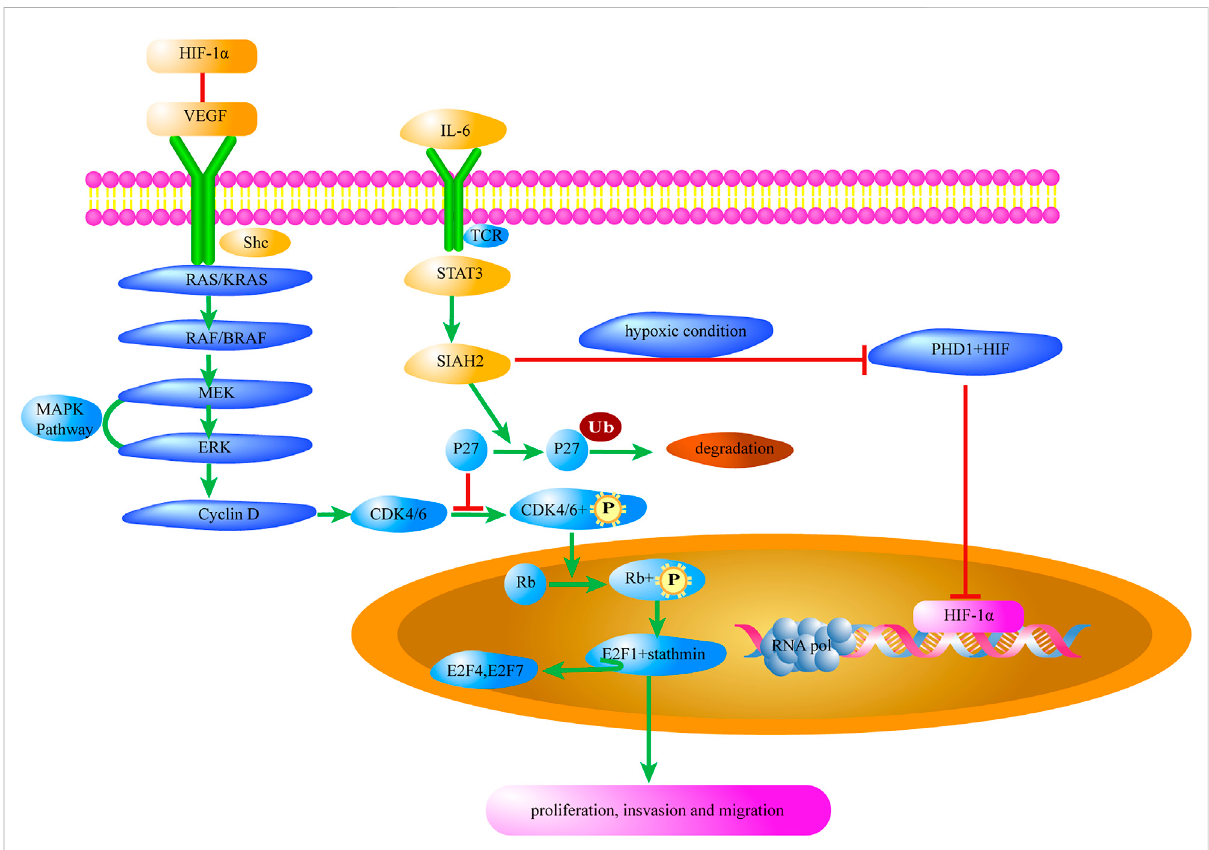
FIGURE 1 MAPK/P27signalingofTregscontributestothetumormicroenvironment.Il-6inthetumormicroenvironmentpromotestheexpressionofHIF- 1 α inTregsandremovestheinhibitionofCDK4/6byP27.Meanwhile,theinteractionbetweenHIF-1 α andVEGFactivatestheMAPK/CDK4/6signaling pathway to promote Treg cell proliferation. HIF-1 α , Hypoxia-Inducible Factor-1 α ; VEGF, Vascular endothelial growth factor; shc, Src-homology collagen protein; RAS, small G-protein; KRAS, V-Ki-ras2 Kirsten ratsarcoma viral oncogene homolog; RAF, Raf kinase; BRAF, v-raf murine viral oncogenehomologB1;MEK,Mitogen-activatedproteinkinase;ERK,Extracellular-signal-regulatedkinase;MAPK,mitogen-activatedproteinkinase; CDK,Cyclin-dependentkinase;Rb,Retinoblastomaprotein;E2F,Transcriptionfactor;P27,Potentialtumorsuppressorprotein;Ub,Ubiquitin;SIAH2, Seven in absentia homolog 2; STAT3, Signal Transducer and Activator of Transcription 3; TCR, T cell receptor;PHD1, Hypoxia-inducible factor prolyl hydroxylase